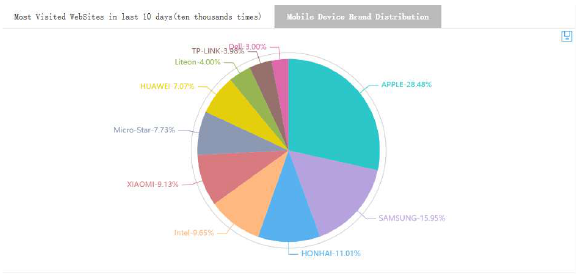
Figure 10. Wireless network